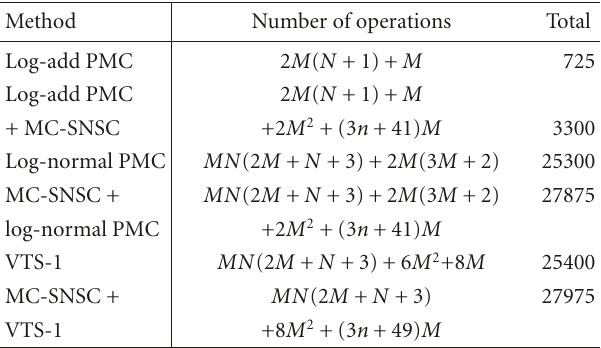
Table 3: Computational complexity of each MC